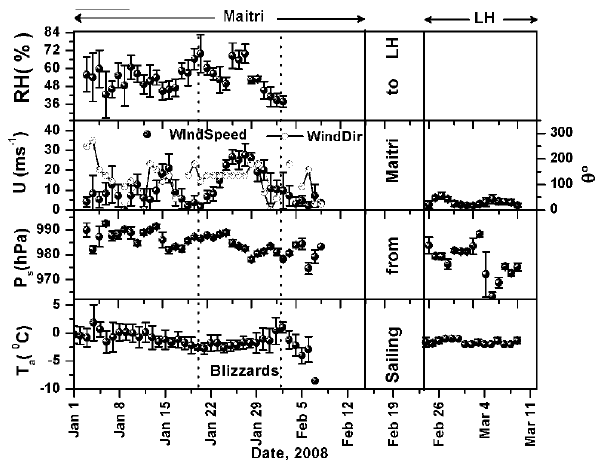
Fig. 2. Graph showing meteorological variations at Maitri and Larsemann Hills. The panels (a) , (b) , (c) , (d) shows the day to day variation of relative humidity, wind speed and direction, pres- sure and temperature. The solid circles represent the mean value for the day and the line passing through it represents the standard deviation from the mean values of the day. The open circles in the wind parameter panel represent the wind direction. The duration of the ship to travel from Maitri to LH is shown by two vertical lines during which no data was collected. The period between the dotted vertical lines represents the duration of a long blizzard (se- vere storm condition occurring frequently at Antarctica, governed by high winds, low pressure, snowfall and snow drift) that occurred at Maitri during the observation